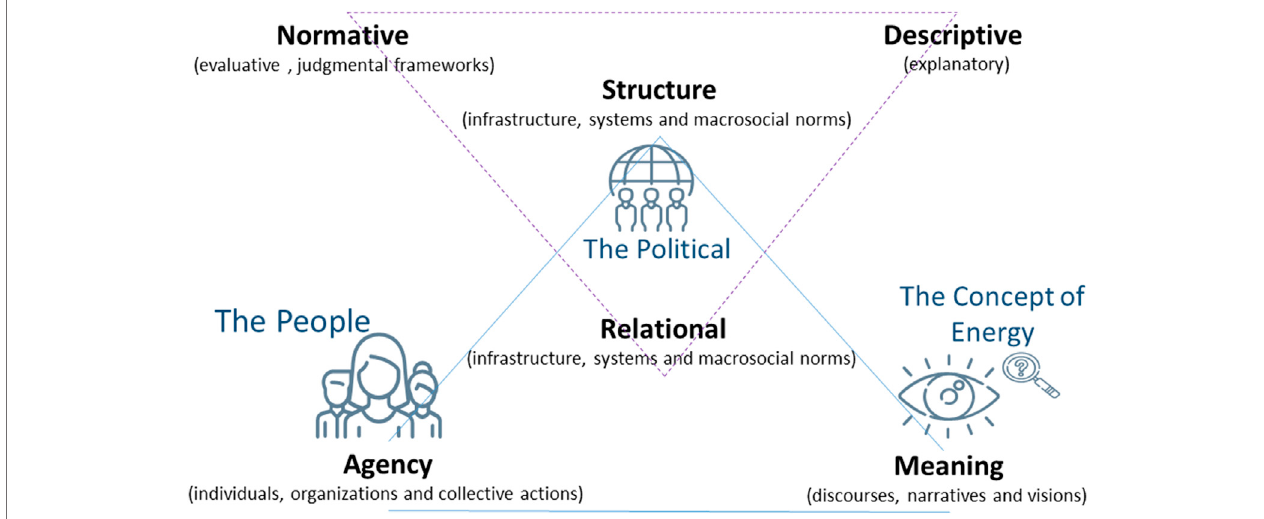
FIGURE 1 | Agency, structure, meaning; relations, normativity and descriptivity in social theories. Adapted from Sovacool and Hess (2017) under the Creative Commons Attribution-NonCommercial 4.0 License.